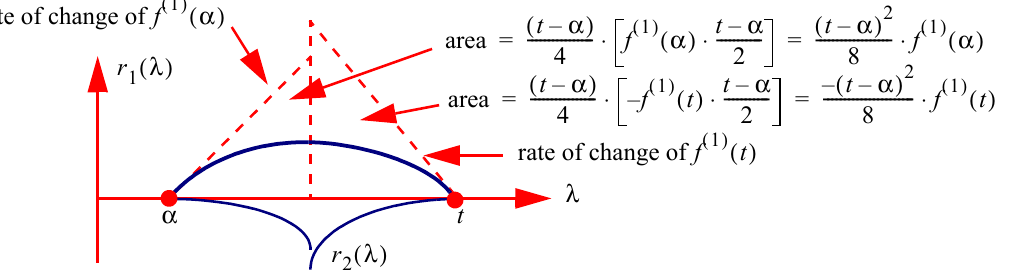
Figure 8. Illustration of the residual function r 1 , the areas as defined by linear change at the points α and t and the second residual function r 2 .